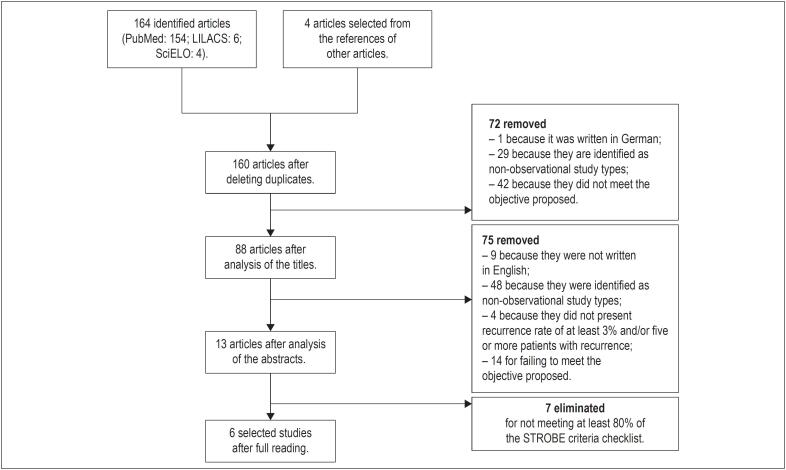
Prisma Flowchart of the studies selection for the composition of the systematic review.